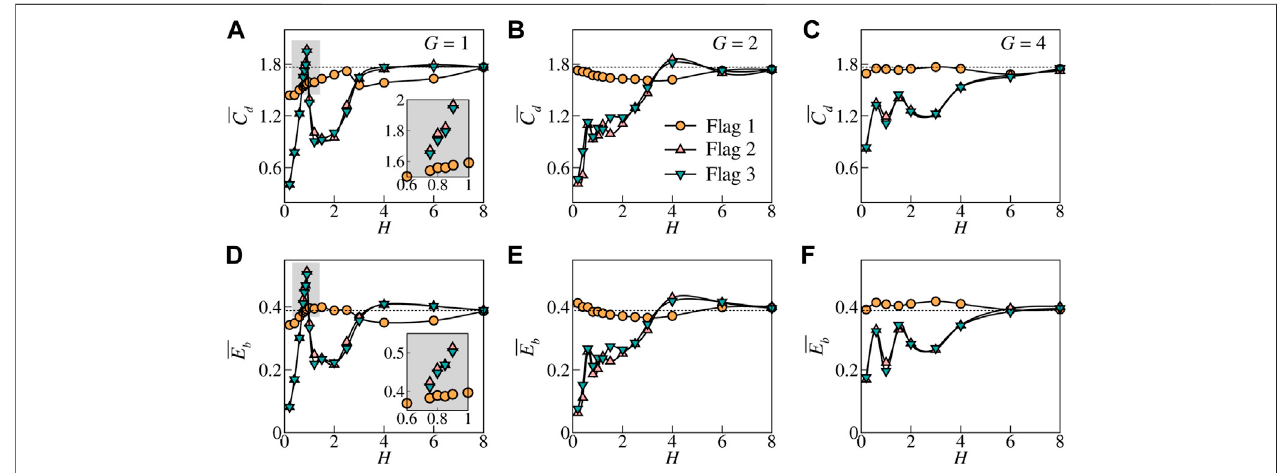
FIGURE 8 | Drag coef fi cient C d (A,B,C) , and bending energy E b (D,E,F) as a function of H for distinct G =1 (A,D) , 2 (B,E) and 4 (C,F) , respectively. The horizontal dash lines represent the corresponding values for an isolated fl ag. Insets in (A,D) : the enlarged view of the harvest enhancement region (with gray color).